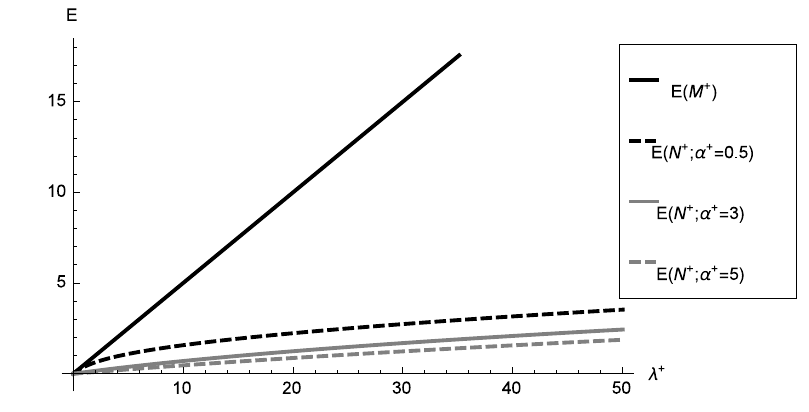
Figure 16 { Plot of the expected values ( E ) of M + and N + versus (cid:21) + for (cid:11) + 2 f 0 : 5 ; 3 ; 5 g